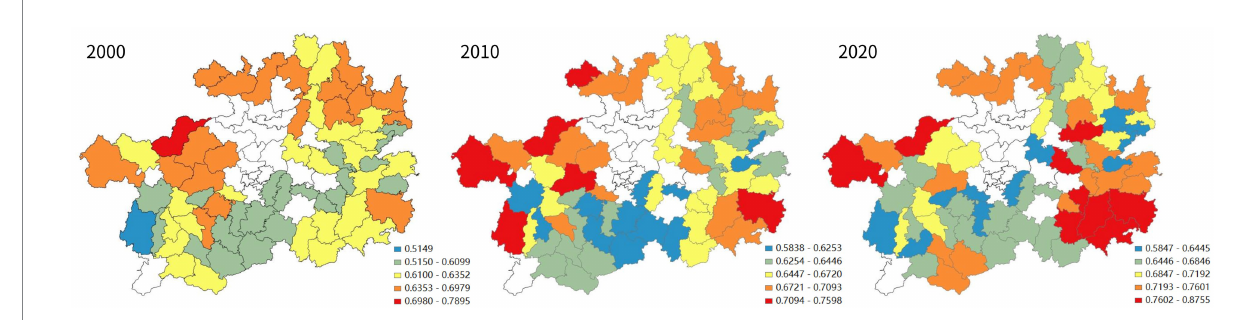
FIGURE 2 Spatial analysis of the changes in quality of life in Guizhou’s districts and counties.